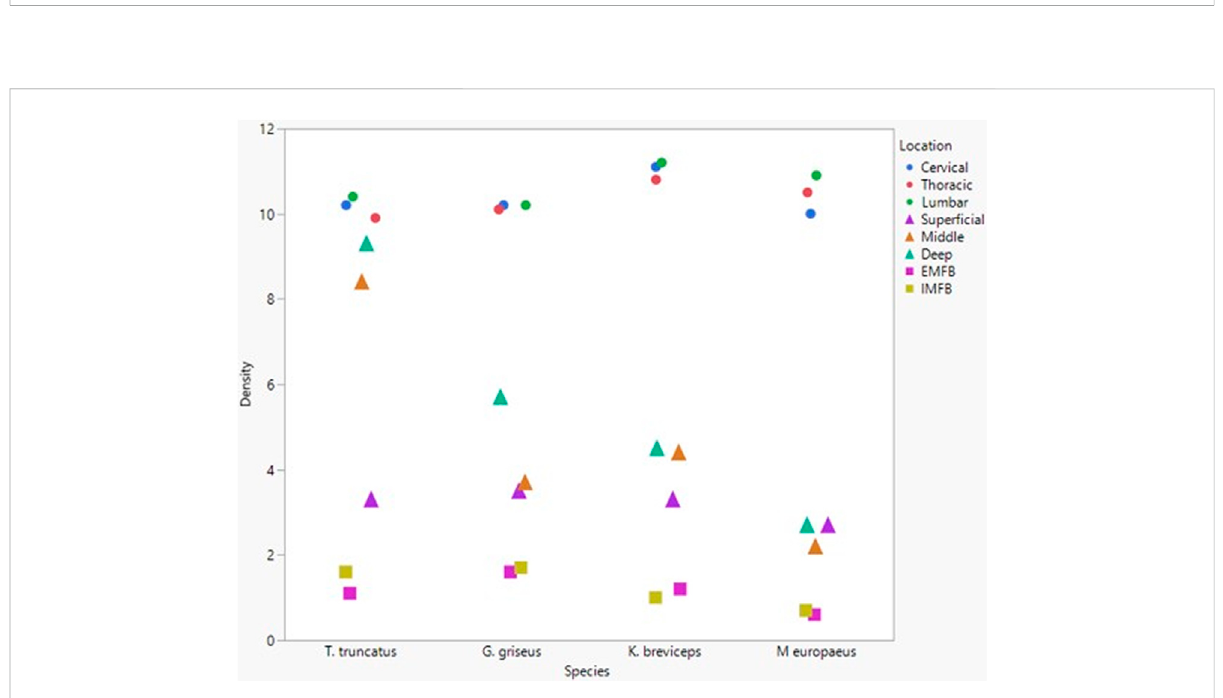
FIGURE 7 Mean microvascular density in odontocete blubber layers (super fi cial, middle, deep) (McClelland et al., 2012; triangle), acoustic fats (intramandibular fat bodies — IMFB and extramandibular fat bodies — EMFB) (Gabler et al., 2018; square), and length of spinal cord (cervical, thoracic, lumbar) (circle)